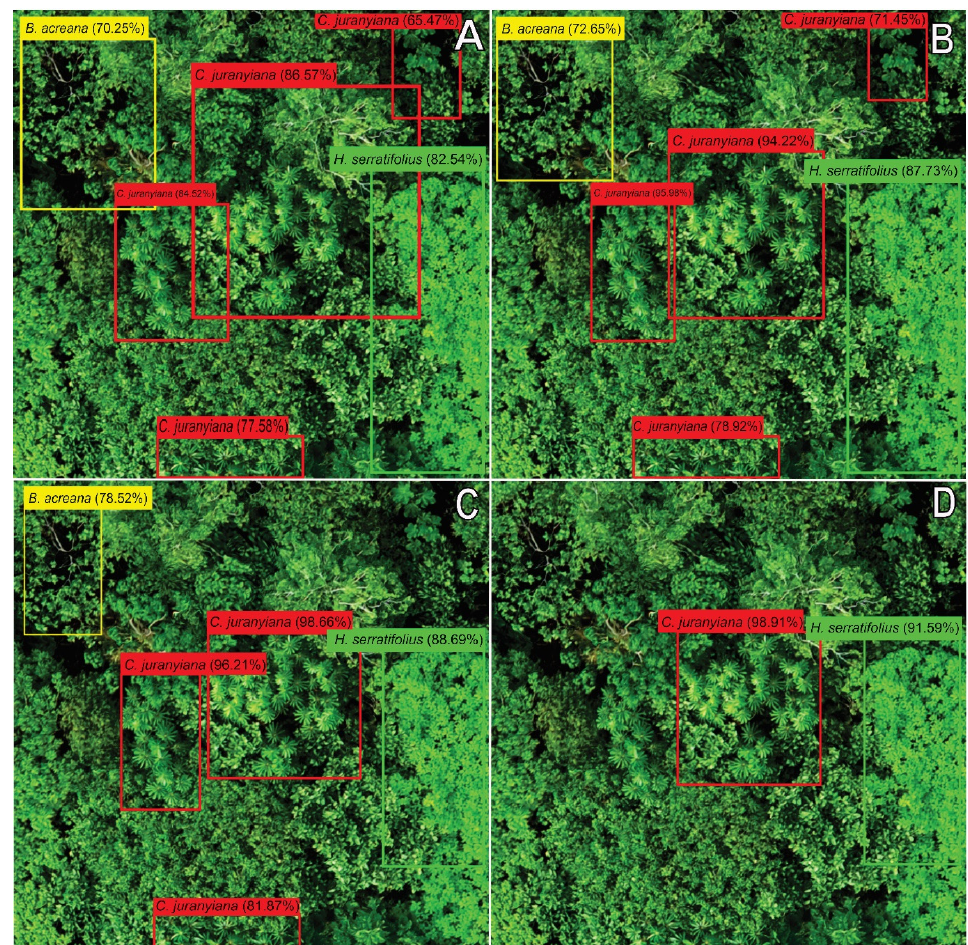
Figure 4. Model application including six species in the training. ( A )—Threshold = 0.9, ( B )—Threshold = 0.8, ( C )—Threshold = 0.7, ( D )—Threshold = 0.6.